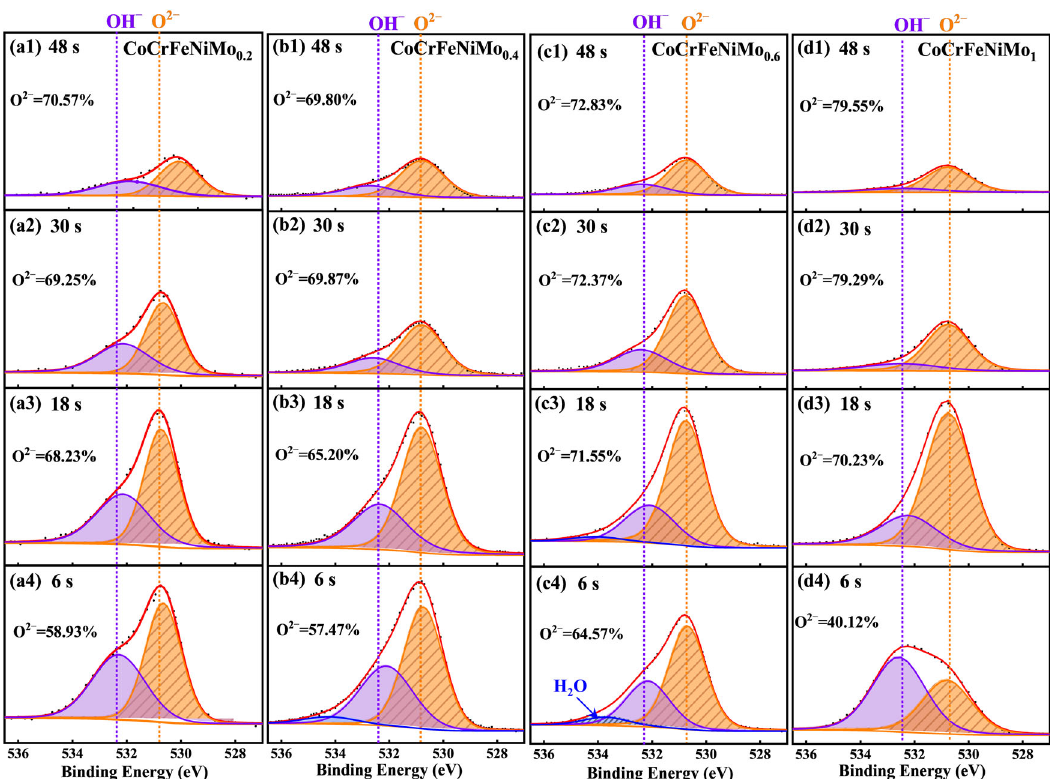
Fig. 10 The detailed XPS spectra of O 1 s of the passive fi lms. a Mo 0.2 , b Mo 0.4 , c Mo 0.6 , and d Mo 1 HEAs.